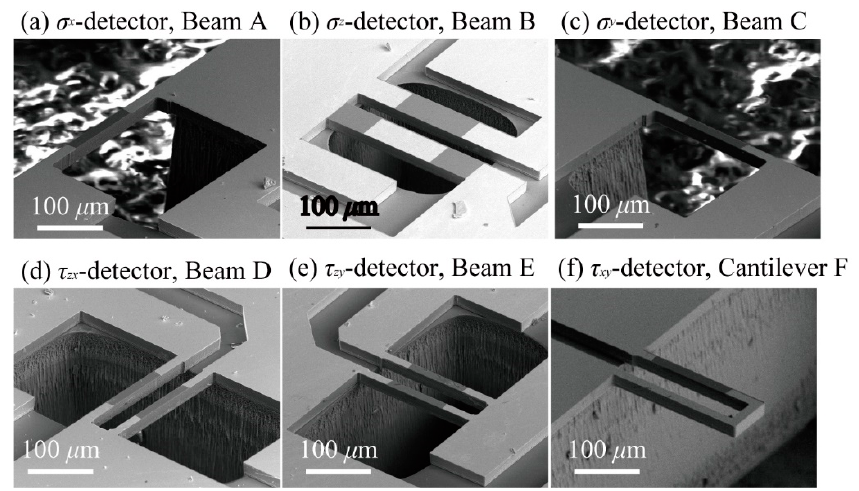
Figure 9. SEM images of the fabricated sensing elements inside the sensor chip. ( a ) SEM image of fabricated Beam A, ( b ) SEM image of fabricated Beam B, ( c ) SEM image of fabricated Beam C, ( d ) SEM image of fabricated Beam D, ( e ) SEM image of fabricated Beam E, ( f ) SEM image of fabricated Cantilever F.